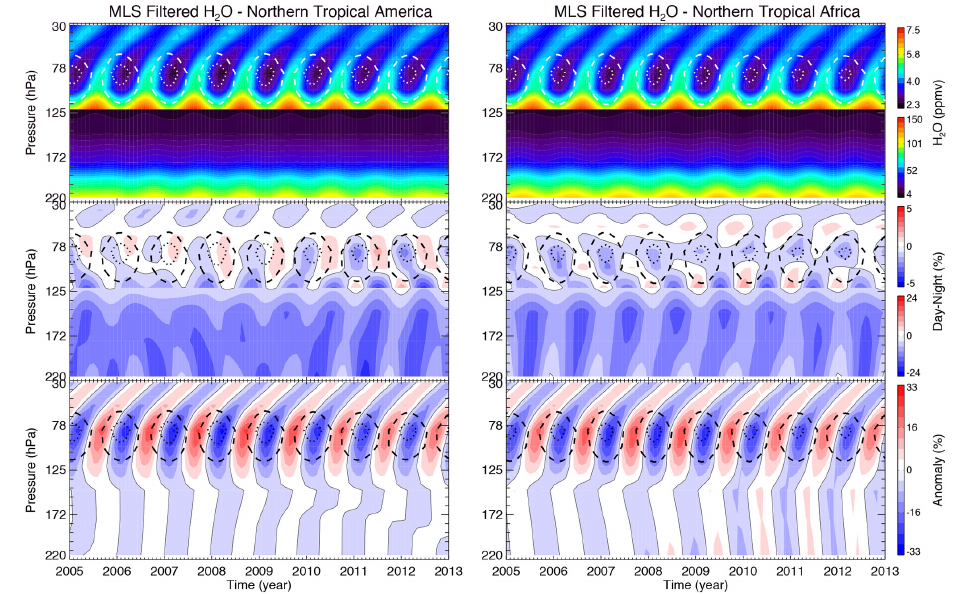
Figure 7a. Same as Fig. 6a but for northern tropical America (left) and northern tropical Africa